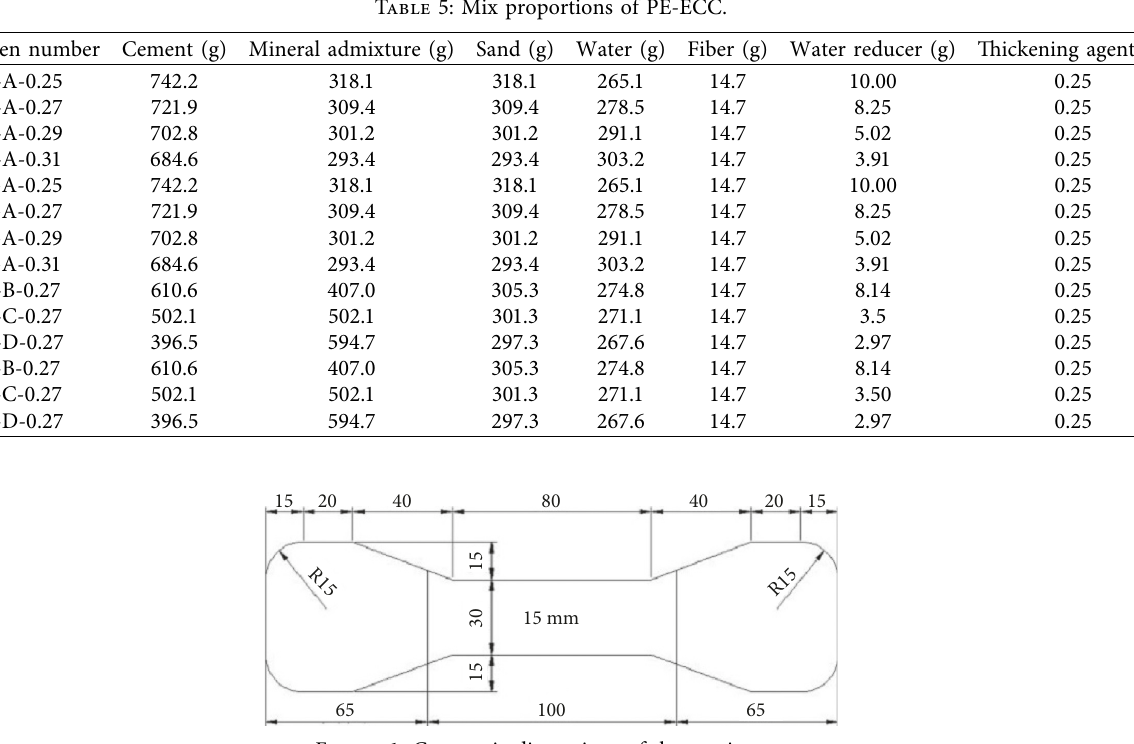
Figure 1: Geometric dimensions of the specimens.